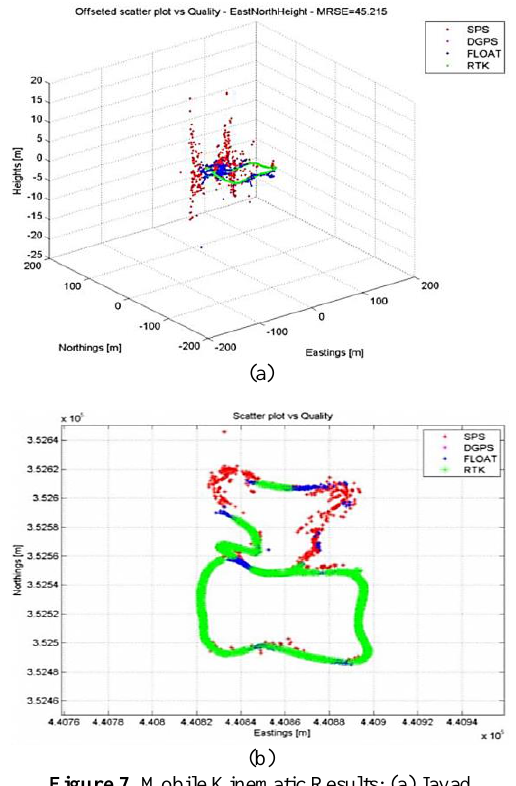
Figure 7. Mobile Kinematic Results: (a) Javad Mobile Kinematic3D; (b) Javad Mobile Kinematic2D.